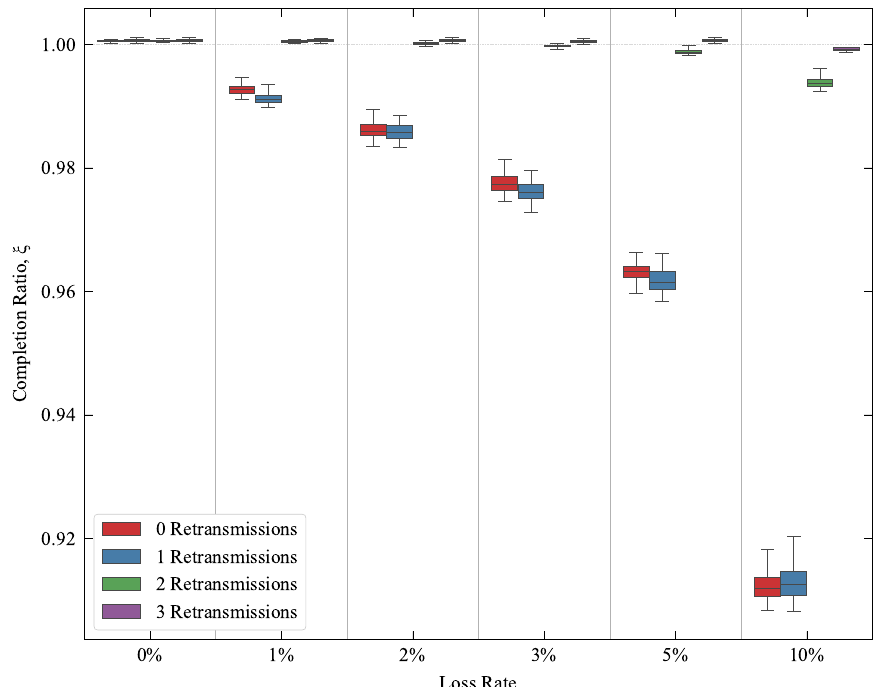
Figure 10. Completion ratios with the numbers of WiFi retransmissions.